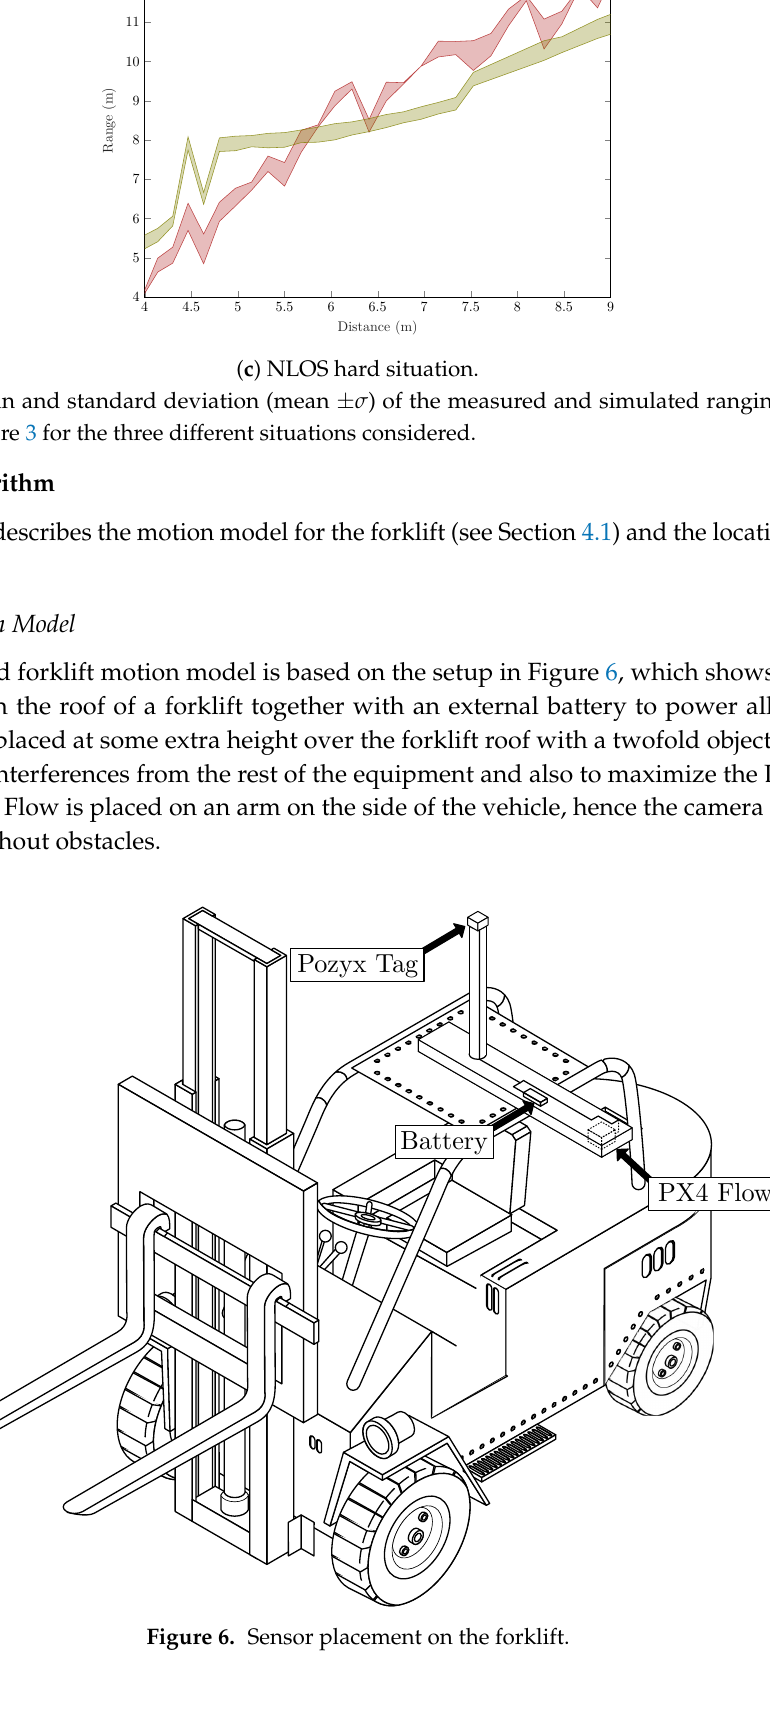
σ ) of the measured and simulated ranging values ±